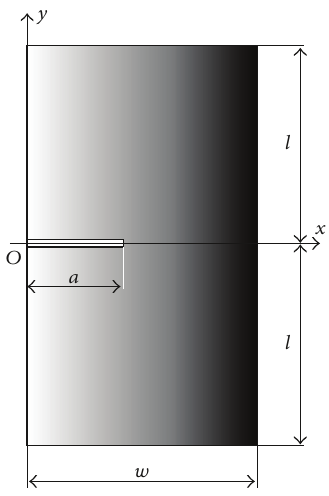
Figure 1: A functionally graded